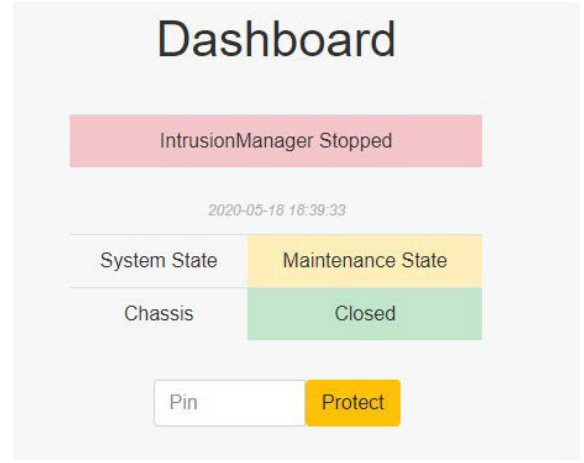
Figure 29. Maintenance state.